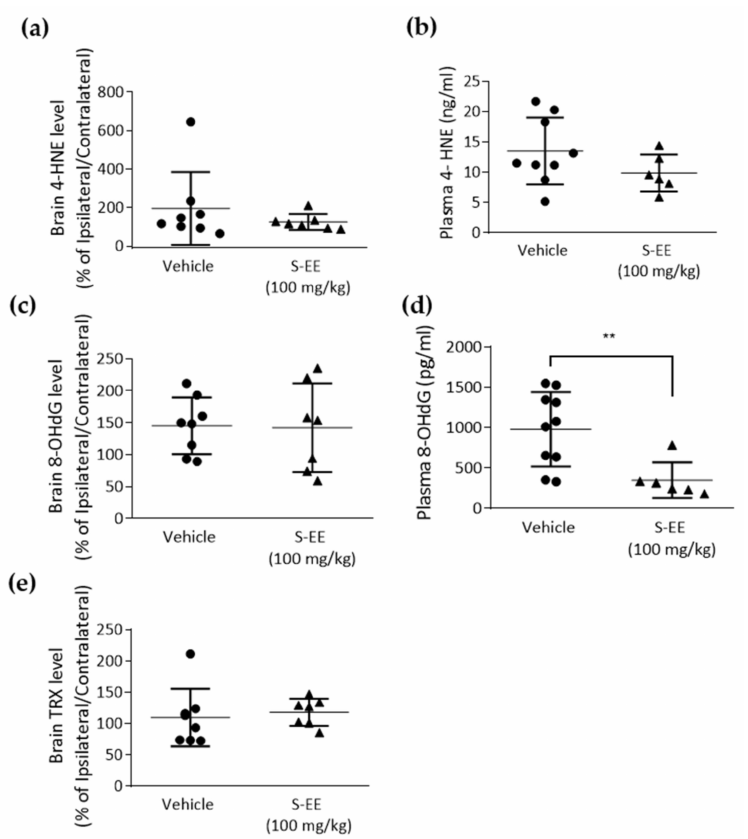
Figure 4. Oxidative stress markers measurement in mice plasma and brain tissue. Samples were collected 24 h after t-pMCAo and analyzed for 4-HNE ( a , b ), 8-OHdG ( c , d ) or TRX ( e ) levels. Data were analyzed using Student’s t-test. Sample size: brain samples (vehicle n = 8; S-EE n = 7), plasma samples (vehicle n = 8; S-E E n = 6). ** p < 0.01 vs.